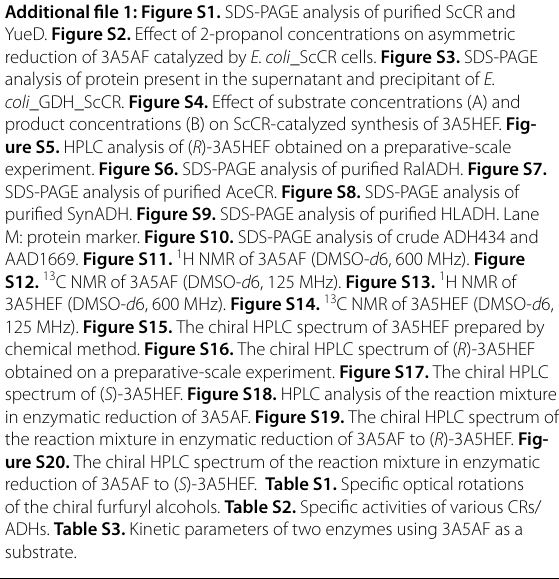
M: protein marker. Figure S10. SDS‑PAGE analysis of crude ADH434 and AAD1669. Figure S11. 1 H NMR of 3A5AF (DMSO‑ d 6, 600 MHz). Figure